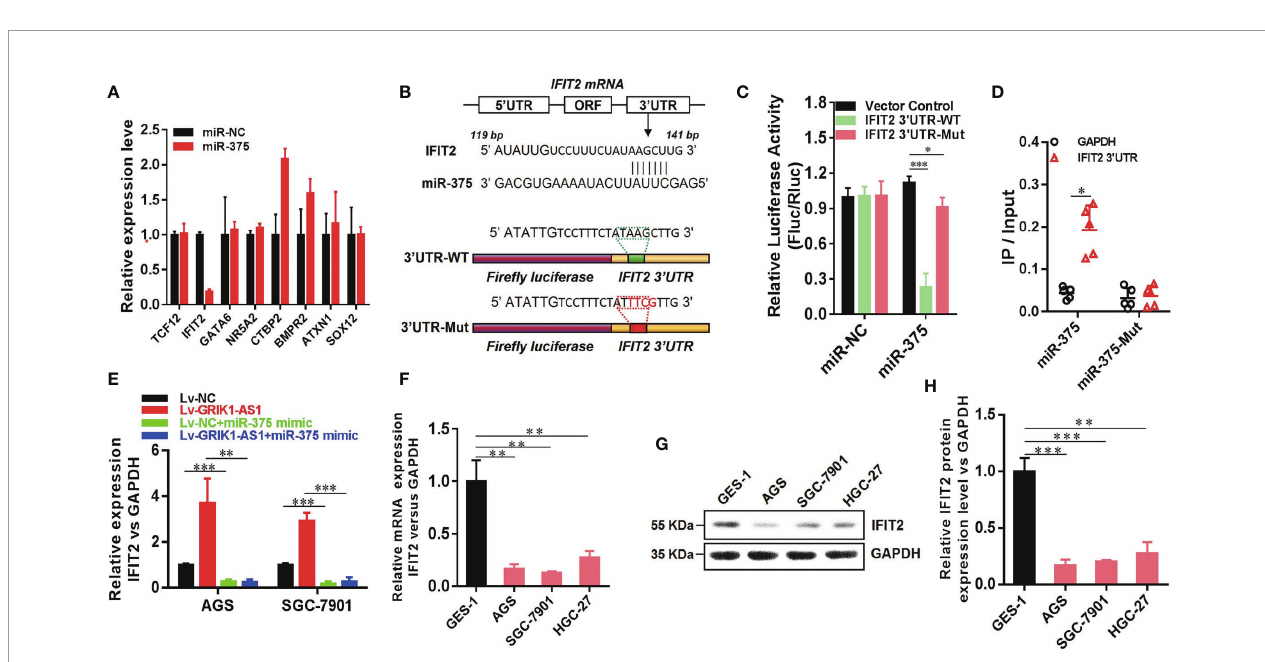
FIGURE 5 | LncRNA GRIK1-AS1 regulates miR-375 to modulate IFIT2 in gastric cancer. (A) . Real-time qPCR was performed to screen out IFIT2 as miR-375 target gene. (B) A schematic diagram showing the putative miR-375 binding sites with IFIT2 3 ’ UTR. (C) IFIT2 3 ’ UTR-WT and IFIT2 3 ’ UTR-Mut luciferase reporter vectors were co-transfected with miR-375 or miR-NC and then subjected to luciferase activity analysis. (D) RNA-pull down was performed to con fi rm the putative miR-375 binding sites with IFIT2 3 ’ UTR. (E) Real-time qPCR analysis of IFIT2 expression level in control and GRIK1-AS1 over-expressed AGS and SGC-7901 cells with or without miR-375 over-expression. (F) Real-time qPCR analysis of IFIT2 expression level in gastric epithelial cell GES-1 and gastric cancer cells AGS, SGC-7901 and HGC-27. (G, H) Western blotting analysis of IFIT2 protein level in gastric epithelial cell GES-1 and gastric cancer cells AGS, SGC-7901 and HGC-27. * P < 0.05, ** P < 0.01, *** P <